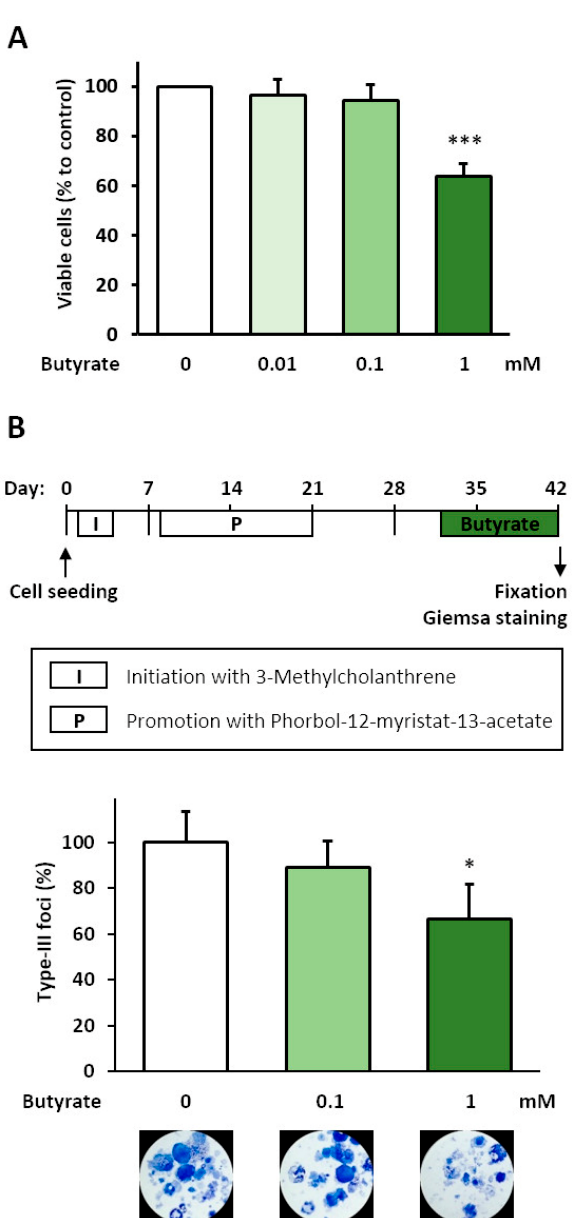
Figure 1. Anti-carcinogenic effect of butyrate in the BALB-TTM. ( A ) Untransformed BALB/c cells at a confluence of 30% were treated with 1 mM butyrate for 48 h. Afterwards, living and dead cells were counted with a ViCell XR cell counter using trypan blue. ( B ) The BALB-TTM was used (see methods). Butyrate was applied in the late phase of malignant cell transformation on Days 32–42. Representative pictures of Giemsa-stained cells and the relative numbers of type-III foci are shown. Statistical differences were calculated from three biological replicates (mean + SD) via a one-way ANOVA (post hoc: two-sided Dunnett-T for the cell count and Bonferroni for the BALB-TTM) with * p < 0.05 and *** p < 0.001 vs. control.